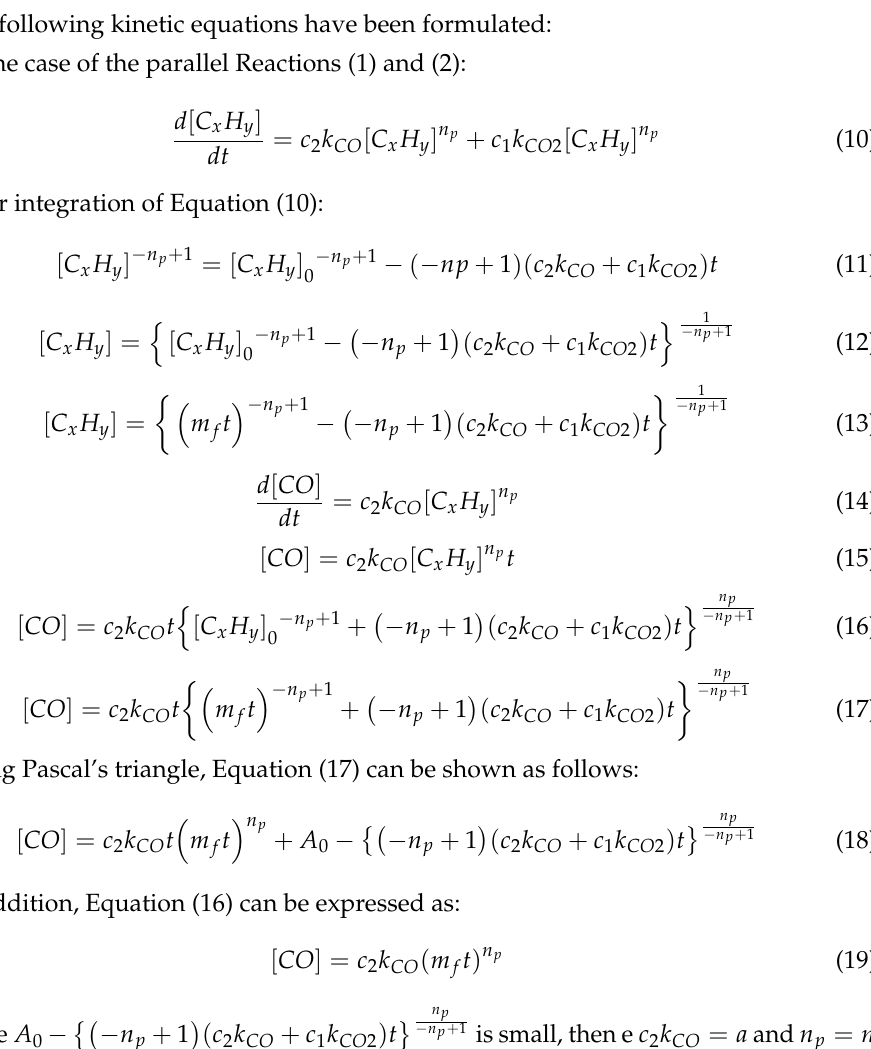
Figure 6. The application of the reactivity model in turbine engine combustion.